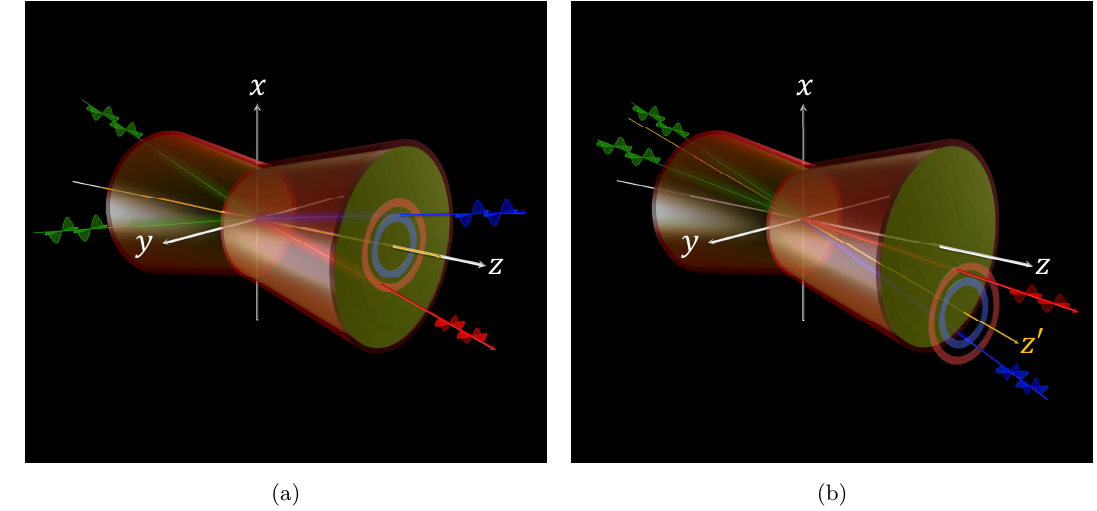
Figure 2 . Classification of collision geometries in QPS. The two figures are extracted from figure 1 of [27]. (a) Symmetric incidence and coaxial scattering, where the incident angles of the two wave vectors and their energies are symmetric, and the transverse momentum of the photon pair, p T , always vanishes with respect to the common optical axis z . (b) Asymmetric incidence and non-coaxial scattering, where the incident angles of the two wave vectors and their energies are asymmetric, resulting in a finite value of p T with respect to the common optical axis z . The zero- p T axis ( z 0 -axis) is always configurable for arbitrary pairs of incident wave